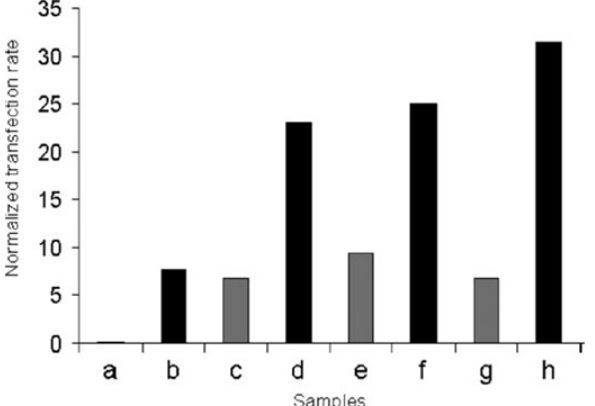
Figure 28. Transfection rates of MDCK cells, normalized with the values obtained for lipofection experiments, using SLNs coated with DNA ( a ); DNA + chitosan: DC ( b );